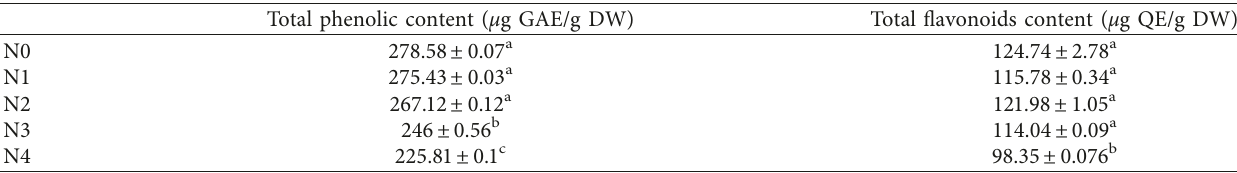
Figure 2: Effect of different levels of N on oil content, total soluble sugars, and total soluble proteins. TSP: total soluble proteins; TSS: total soluble sugars. Data labeled with different letters are significantly different at p < 0 . Table 1: Effect of different levels of N on total phenolic and total flavonoids content of hydromethanolic extracts of sesame seeds.